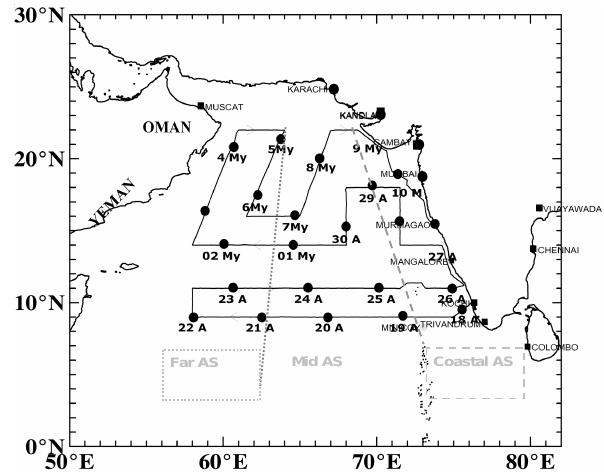
Fig. 1. The cruise legs (solid lines) of the Sagar Kanya 223B in the Arabian Sea in the period 18 April–10 May 2006 with indications of the daily position of the ship at 05:30UTC denoted by the circles. The major ports and coastal urban centers on the mainland adjoining the cruise track are also identified. The date at each position also indicated (A=April,